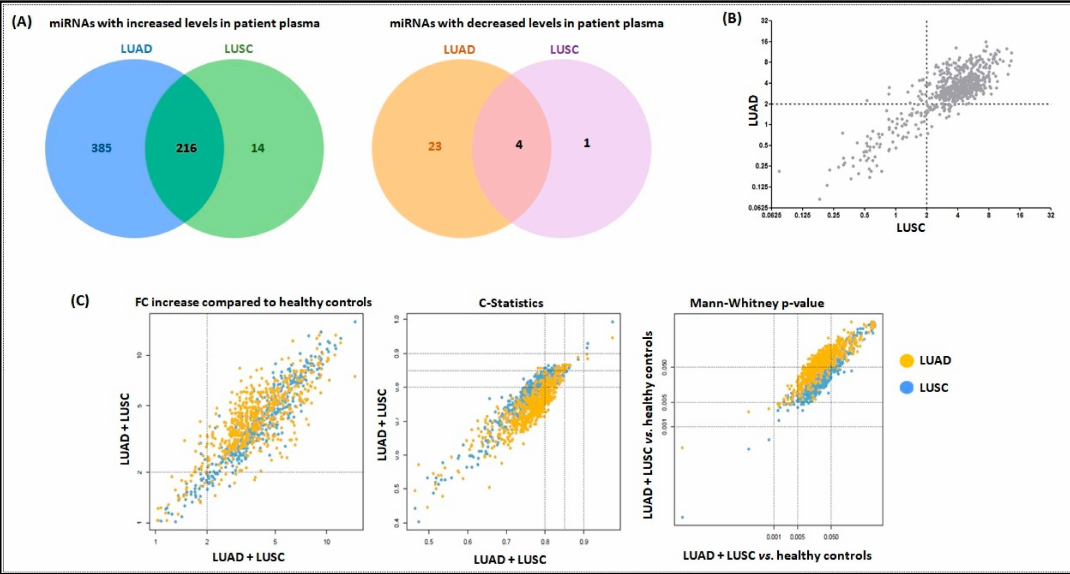
Figure 1. miRNAs have commonly deregulated levels and are correlated in patient plasma. Panel ( A ) shows the Venn diagram with the distribution of miRNAs that showed significantly increased or decreased levels in plasma from LUAD and LUSC patients, respectively. Most miRNAs have similar levels of deregulation in patient plasma independent of tumor histology. LUAD: lung adenocarcinoma; LUSC: lung squamous cell carcinoma. Panel ( B ) shows the correlated expression for the 800 miRNAs in the Nanostring nCounter panel (Spearman test, r = 0.67, p < 0.0001). Note that most miRNAs have FC ≥ 2.0 in plasma from patients with both tumor histologies. Panel ( C ) are the scatter plots to depict a high correlation between overexpressed miRNAs in plasma from patients with LUAD and